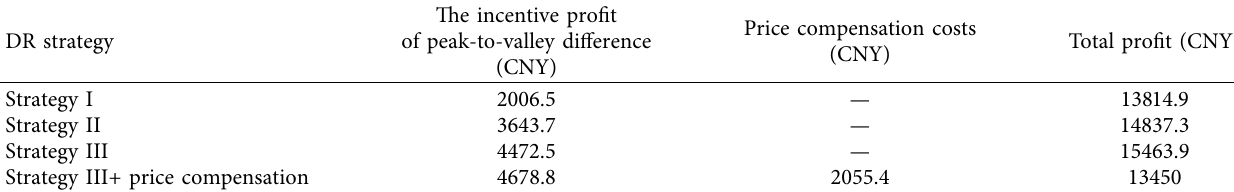
Table 9: Aggregator total proft under diferent DR strategies.